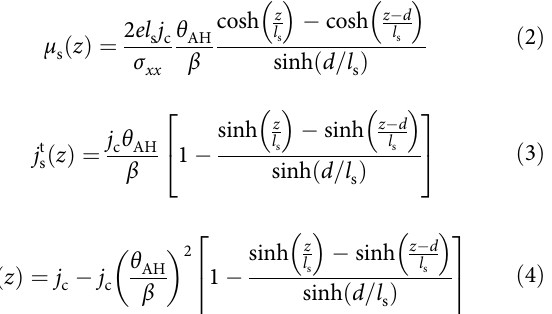
Fig. 3 Correlation of MR( θ zy ) and AHE. a MR( θ zy ) results for co-sputtered (Fe 1 − x Mn x ) 0.6 Pt 0.4 with x = 0.22 – 0.65. b – c Mn composition dependence as a function of ρ xx . e MR ratio as a function of θ AH for a variety of samples including Fe, Fe 1 − x Pt x , of ρ xx , ρ AH xy and M s , respectively. d ρ AH xy = M s (Fe 1- x Mn x ) 0.6 Pt 0.4 , and Fe 1 − x Mn x . Solid lines in a are fi ttings based on the angle dependence. Inset of d shows the full range of ρ AH xy = M line in d serves as a guide for the eye. The shadowed area in e is the calculated AHMR ratio range using different combinations of β : 0.4 – 0.6 and l s : 2 – 5 nm, and dotted line in e is the fi tting results using β = 0.55 and l s = 3.5 nm. The error bars in d are from the linear fi tting to determine ρ